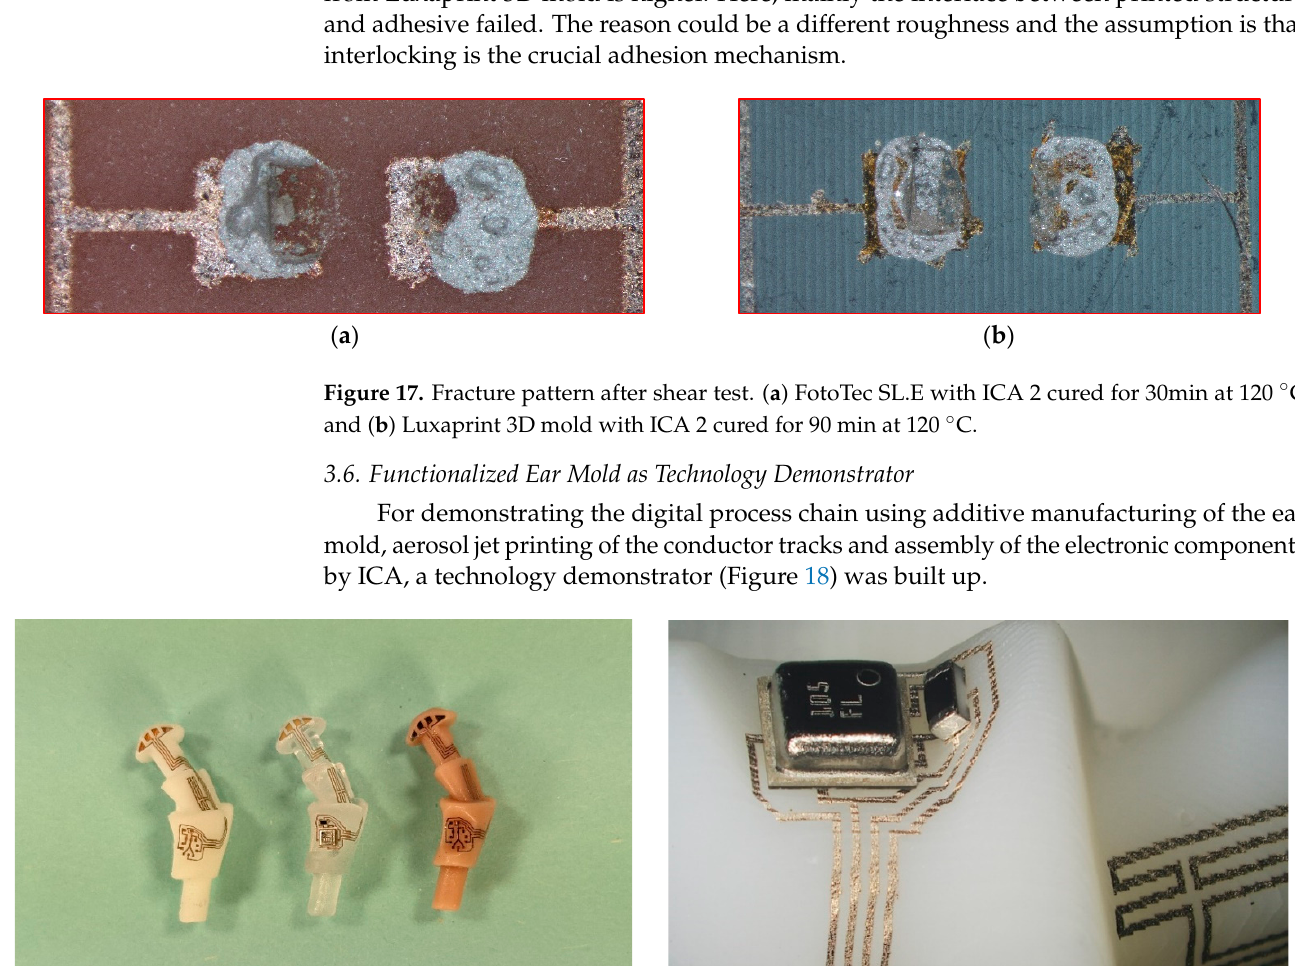
Figure 16. Shear forces of 0603 SMD components with different curing profiles.